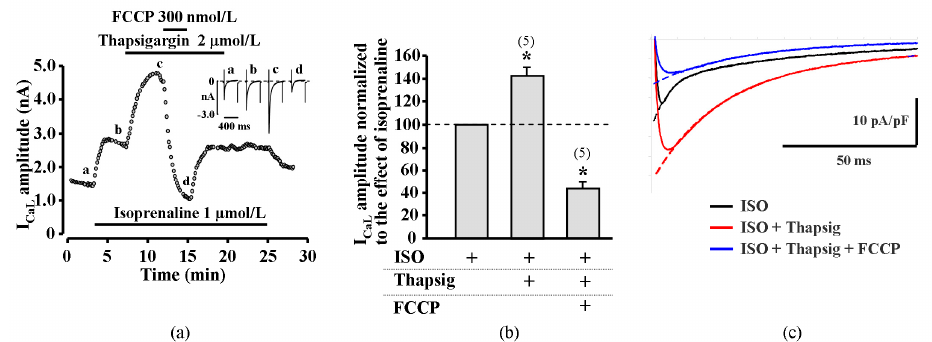
Figure 3. Effect of FCCP on isoprenaline stimulated I CaL in rat cardiomyocytes after the suppression of cytosolic Ca 2+ release. ( a ) A typical experiment representing the effect of FCCP on I CaL in ISO-stimulated cells during exposure to thapsigargin. Traces of I CaL shown in the panel were recorded at the times indicated by the corresponding letters on the main graph. ( b ) Peak amplitude of I CaL during exposure of ISO-stimulated rat ventricular cells to FCCP in the presence of thapsigargin. Values are presented as means ± SEM for the number of cells indicated in parentheses. * p < 0.05 versus ISO alone. ( c ) The time dependent inactivation of LTCCs currents. Traces of I CaL in isoprenaline (ISO, 1 μ mol/L) stimulated (black line) rat cell during application of thapsigargin (Thapsig, 2 μ mol/L) (red line) and metabolic inhibition by FCCP (0.1 μ mol/L) (blue line). Dashed lines represent double exponential fits of I CaL s decay.